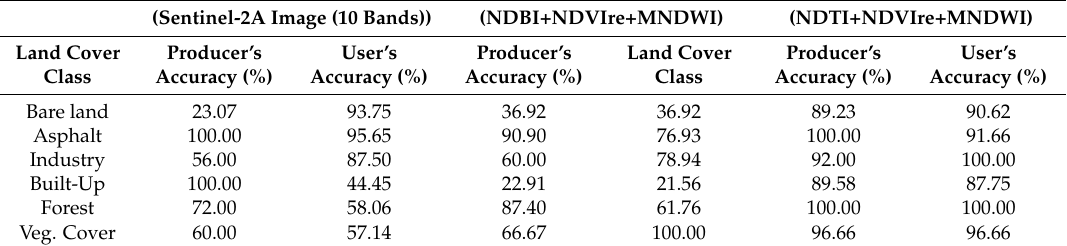
Table A3. Classification accuracies of the different approaches for Figure